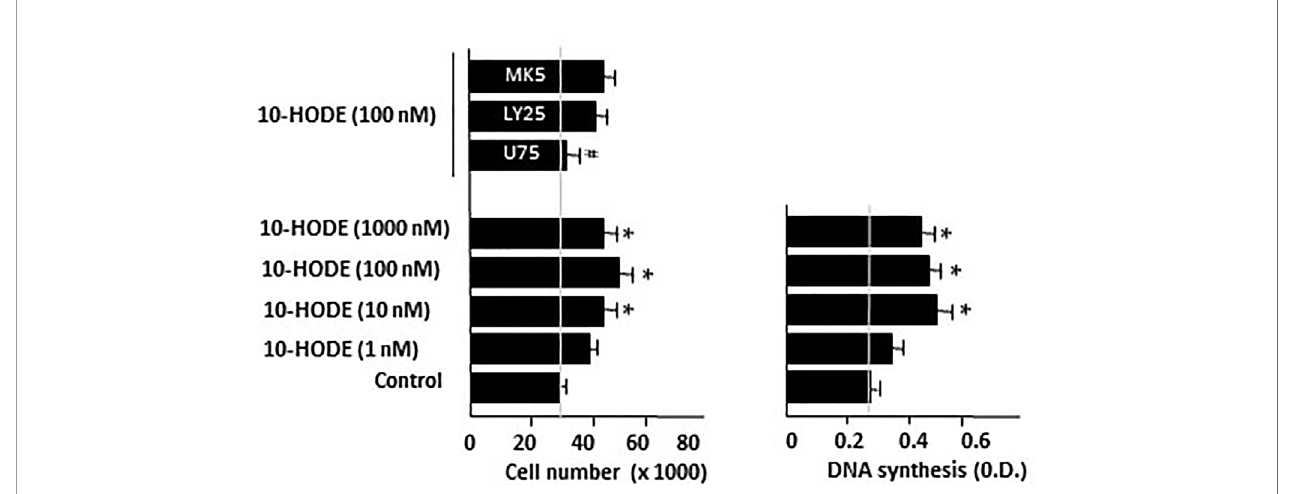
FIGURE 6 | Effect of 10-HODE on Caco-2 cell growth and DNA synthesis. 10-HODE was incubated with Caco-2 cells without FBS in presence of U75302 (U75, 5 µM), LY25283 (LY25, 25 µM), or MK571 (MK5, 25 µM) for 48 h and then cells were counted or DNA synthesis assayed by cell BrdU incorporation. Results are expressed as mean ± SEM (n = 6 – 9) *P < 0.05 vs control group (cells cultured without FBS), # P < 0.05 vs 10-HODE (100 nM), N.D., non determined.